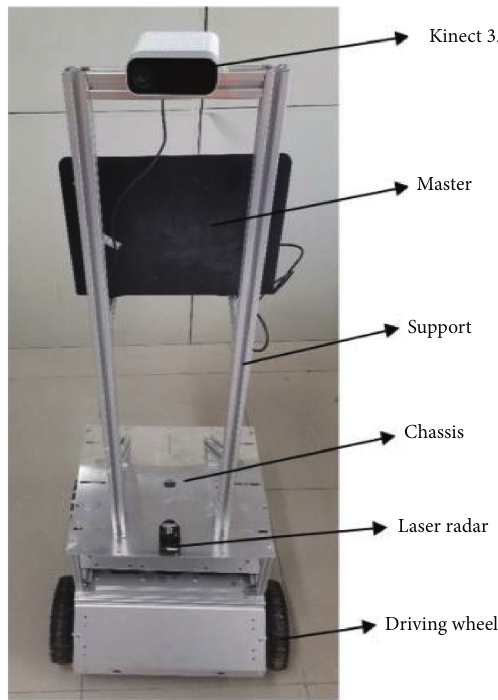
Figure 6: Experimental platform of robots.